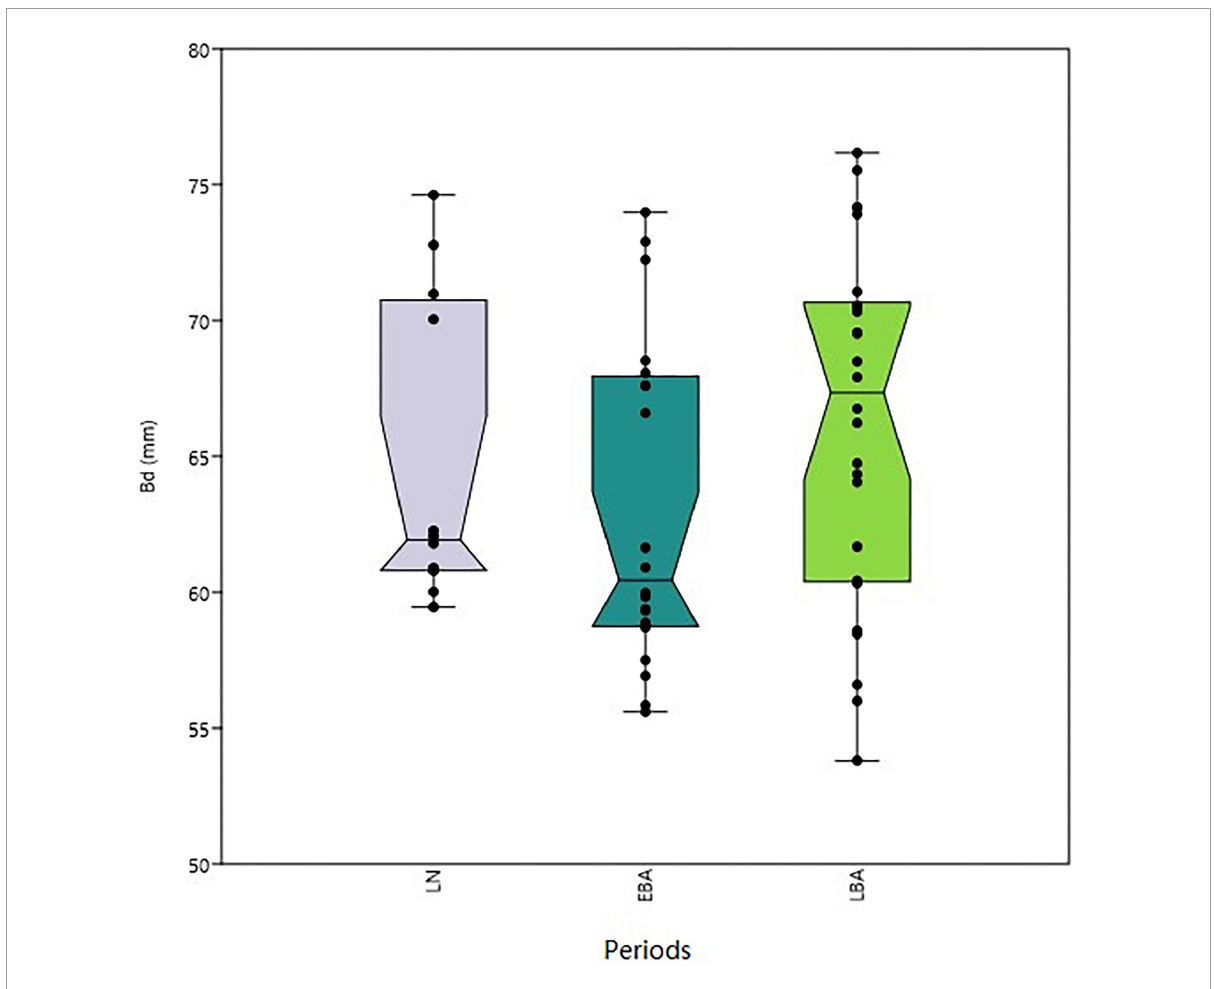
FIGURE2 Boxplots showing median, inter-quartile range, and maximum and minimum values for cattle metacarpal